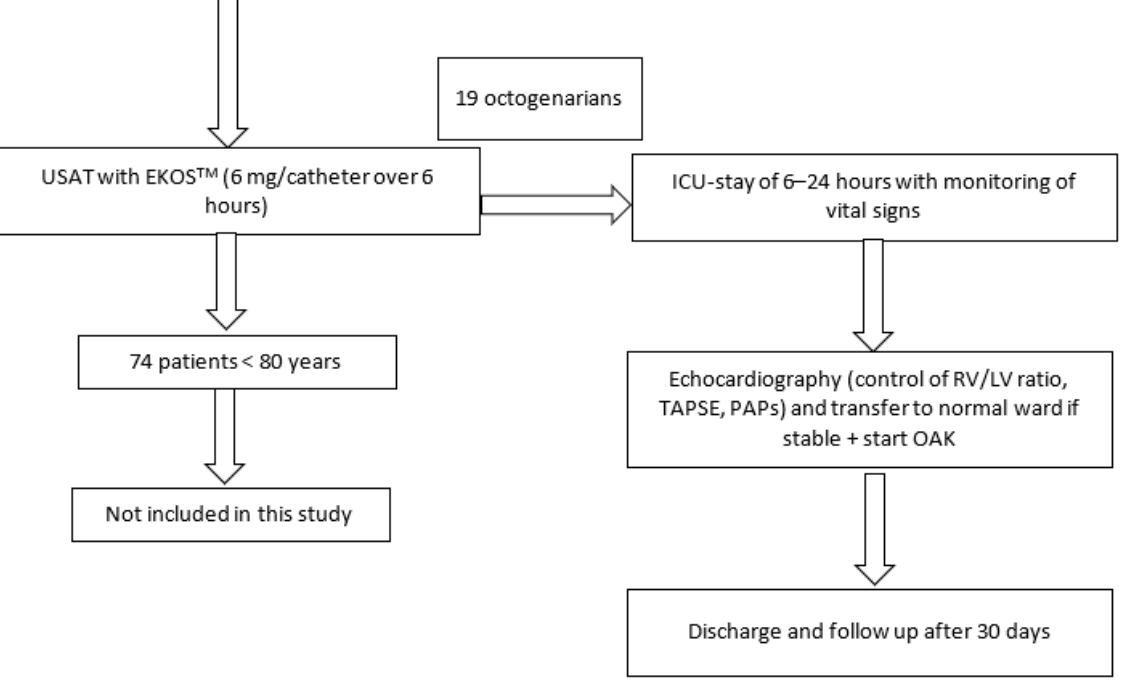
Figure 1. Study fl owchart.